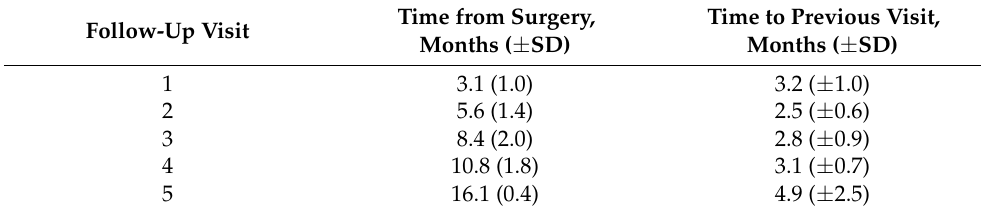
Table 2. Follow-up timeline in months,